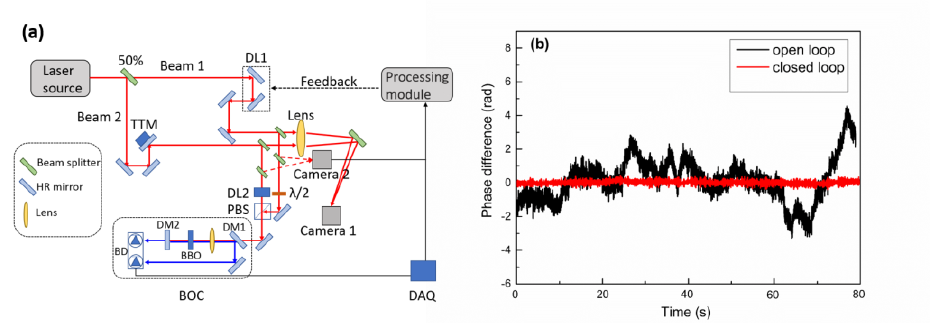
Fig. 1. (a)Experiment setup. BD, balanced photodetector; BOC, balanced optical cross-correlator; DL1/DL2, delay line; DM1, dichroic mirror, AR at 800 nm, HR at 400 nm; DM2, dichroic mirror, AR at 400 nm, HR at 800 nm; PBS, polarization beam splitter; TTM, tip-tilt mirror; BBO, beta barium borate crystal; DAQ, data acquisition card. (b) Phase errors recorded in an open loop and closed loop.